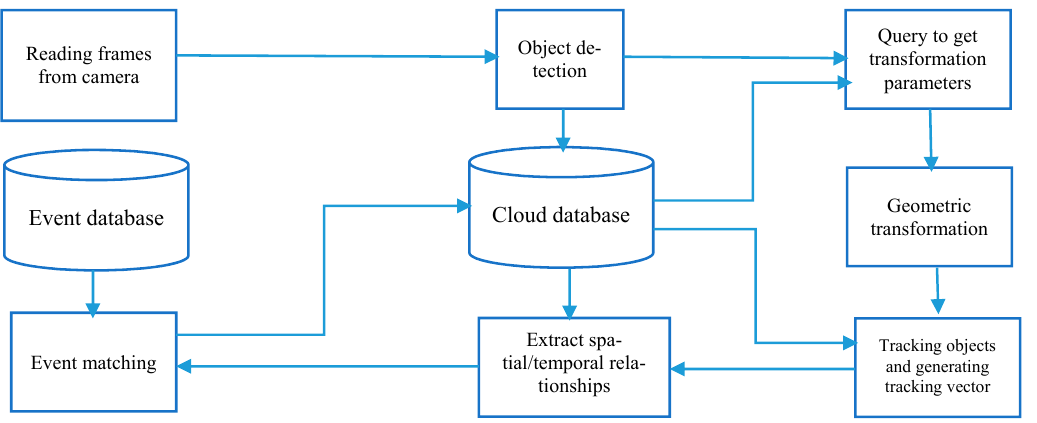
Figure 2. Event matching steps in the cloud.